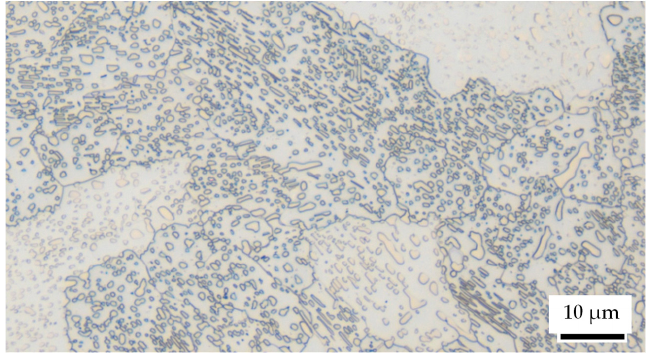
Table 2. Chemical composition of the plates for singe-impact peening.